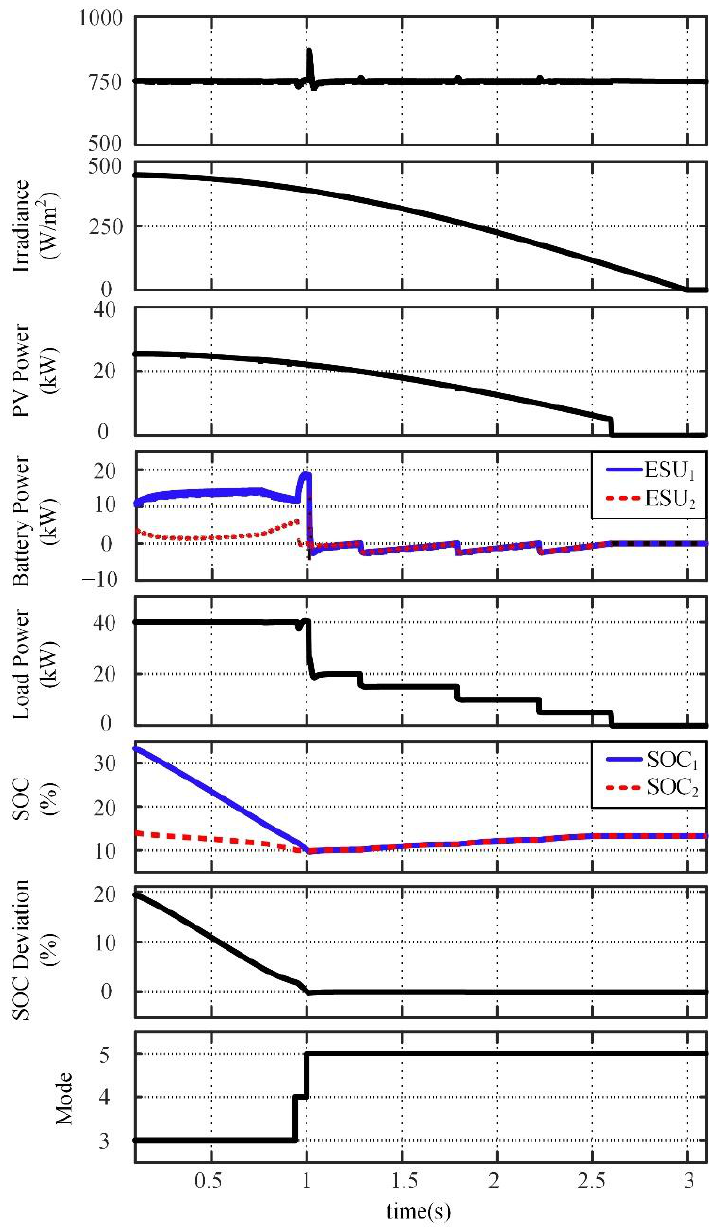
Figure 12. Response to removal of the load.